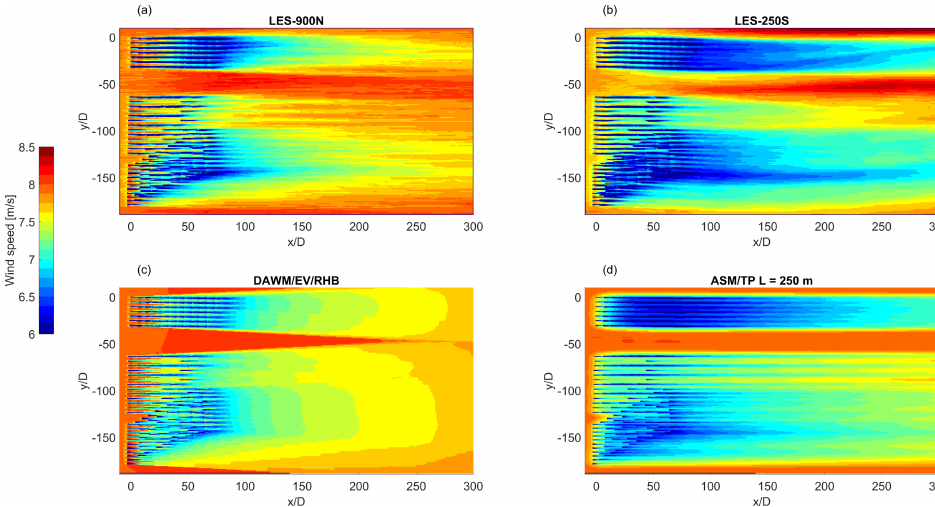
Figure 6. Horizontal cross-sections at hub height of the LES and Openwind horizontal wind speed (see colorbar left) for the ( a ) LES-900N, ( b ) LES-250S, ( c ) DAWM/EV/RHB and ( d ) ASM/TP